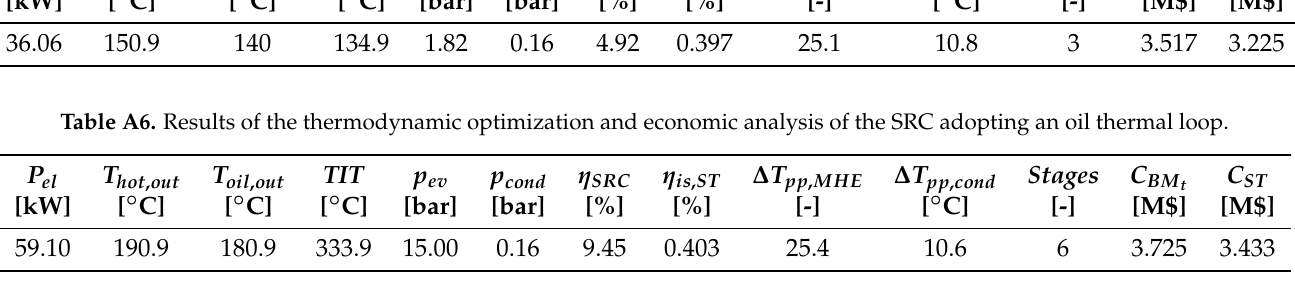
Table A5. Results of the thermodynamic optimization and economic analysis of the SRC adopting a water thermal loop. P el T hot , out T water , out